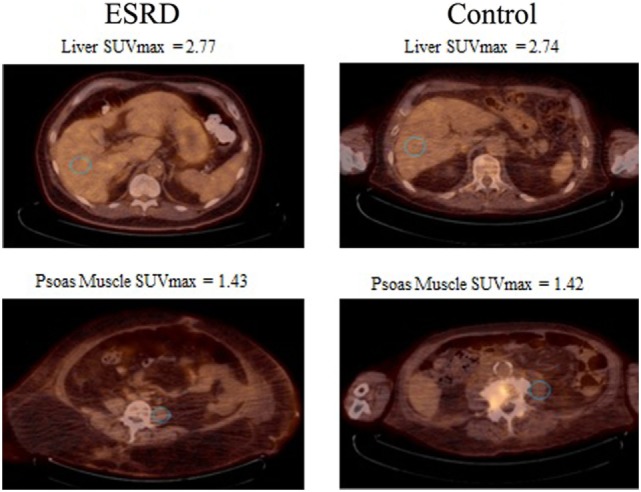
30 mm circular regions of interest (blue) were placed. The first in the right hepatic lobe and second in the left psoas muscle. In addition, the figure shows the mean standard uptake values (SUVs) between the controls and the renal failure patients.